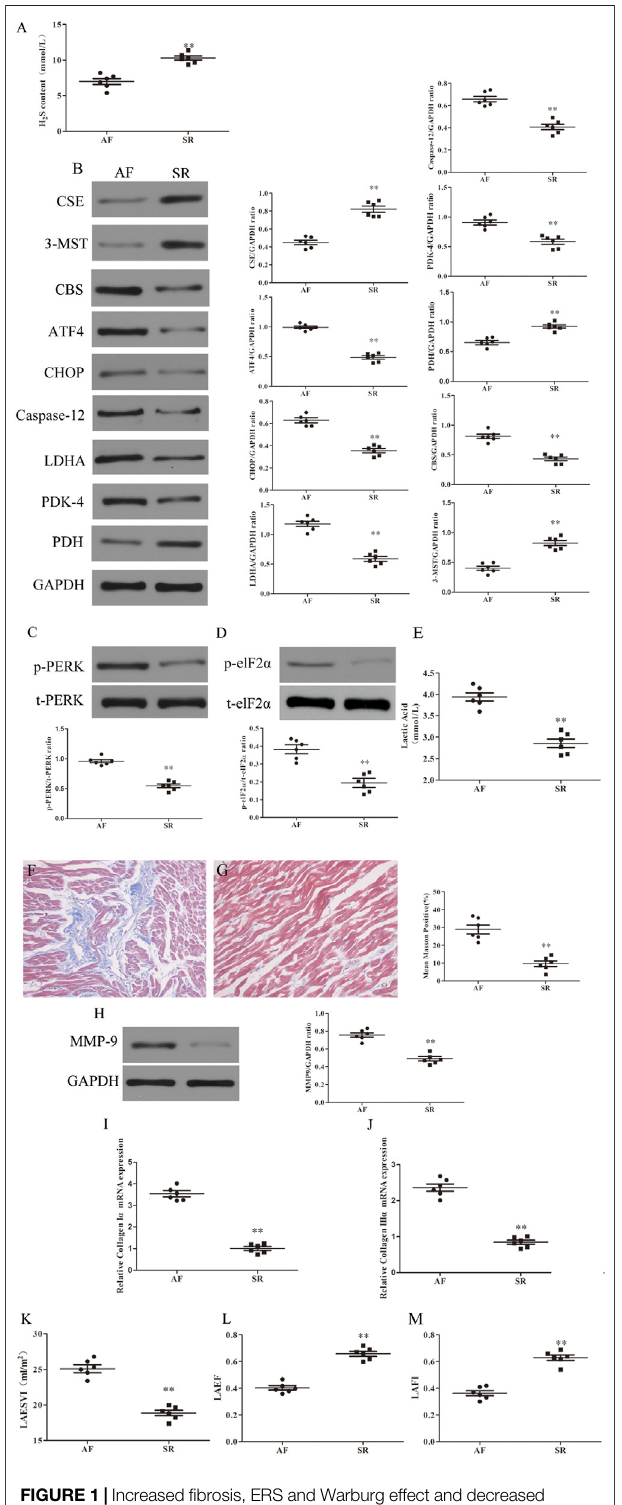
FIGURE 1 | Increased fi brosis, ERS and Warburg effect and decreased CSE expression and left atrial function were found in AF patients compared with SR patients. (A) H 2 S content was determined by Methylene blue method in the LAA of patients with SR or AF ( n (cid:1) 6 in each group). (B)